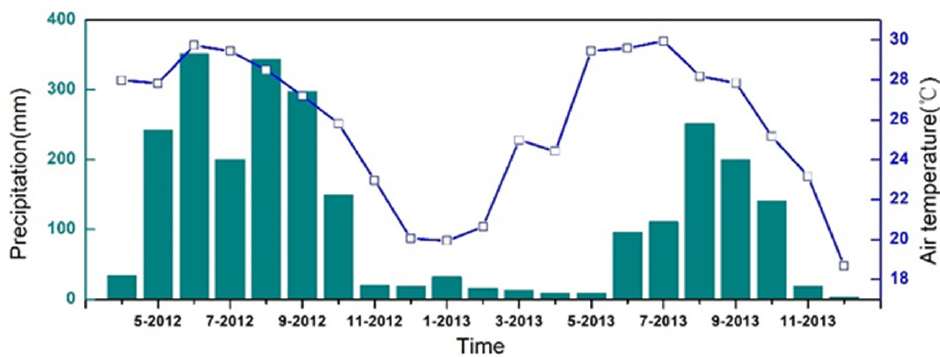
Figure 1. Meteorological data of the study area from April 2012 to December 2013 (data were from a weather station set by the Institute of Tropical Forestry, Chinese Academy of Forestry).